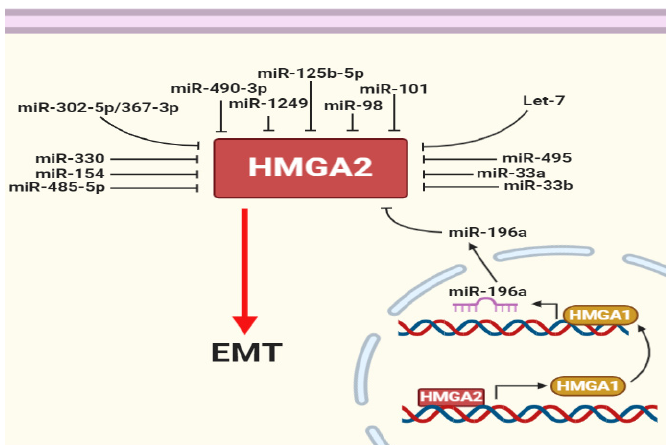
Figure 3. HMGA2 is regulated by multiple microRNAs. HMGA2 regulates itself by promoting HMGA1 and then HMGA1 decreased HMGA2 by increasing miR-196a . In addition, several microR- NAs (miRNAs) have been shown to repress epithelial–mesenchymal transition (EMT) by target- ing